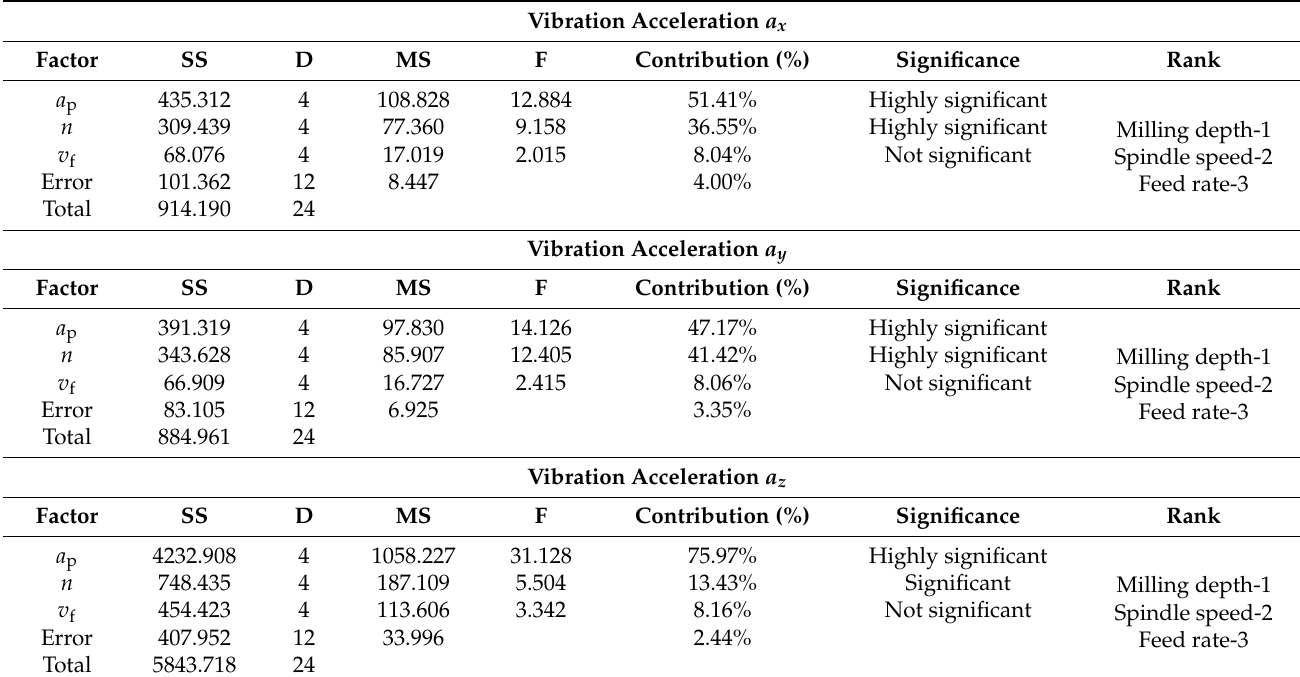
Table 11. Variance analysis results of vibration acceleration orthogonal